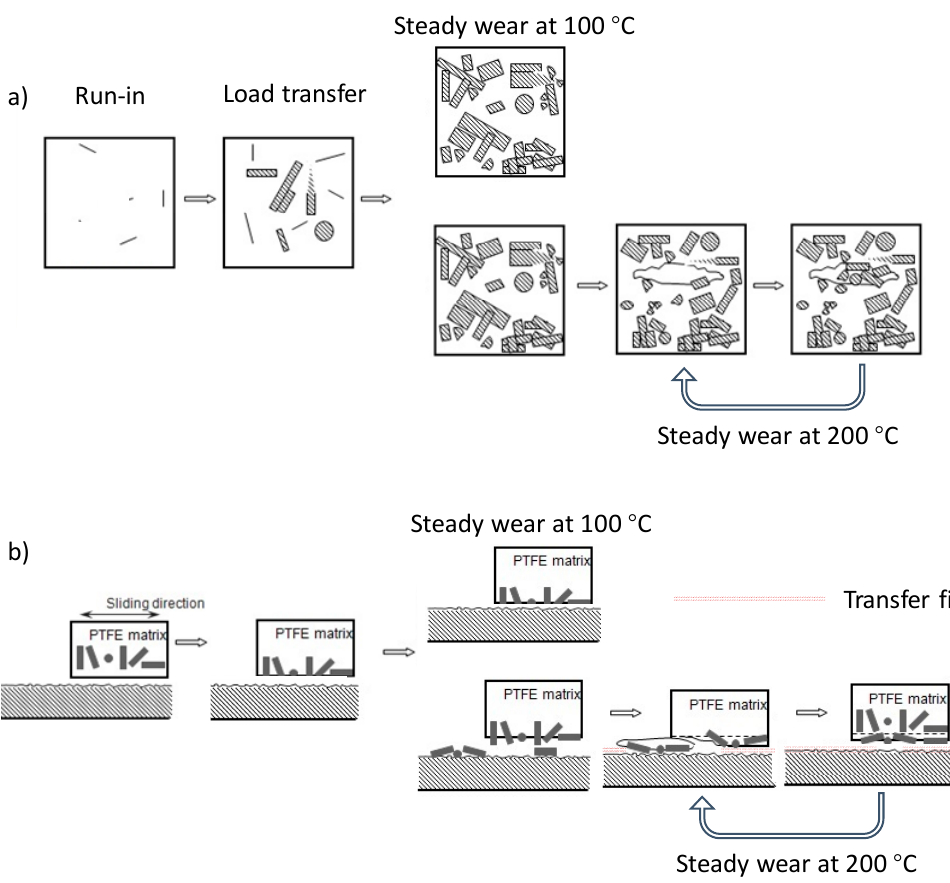
Figure 11. The schematic of the wear evolution of GFRPTFE sliding against steel counter-face. ( a ) Top view and ( b ) cross-section view.